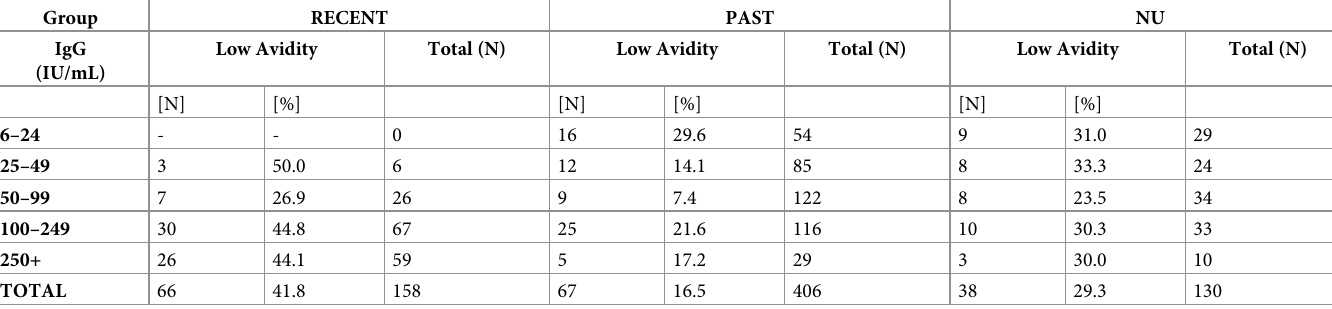
Table 3. Percentage of low anti- Toxoplasma IgG avidity in 694 samples categorised by IgG concentration. Group